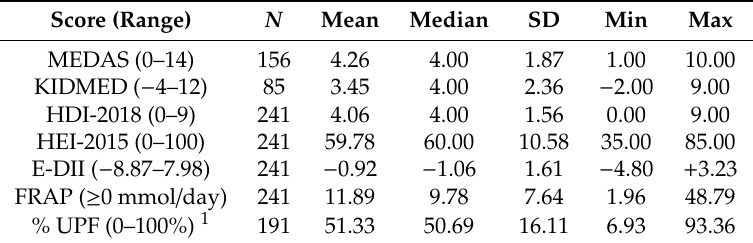
Table 2. Descriptive statistics of the dietary